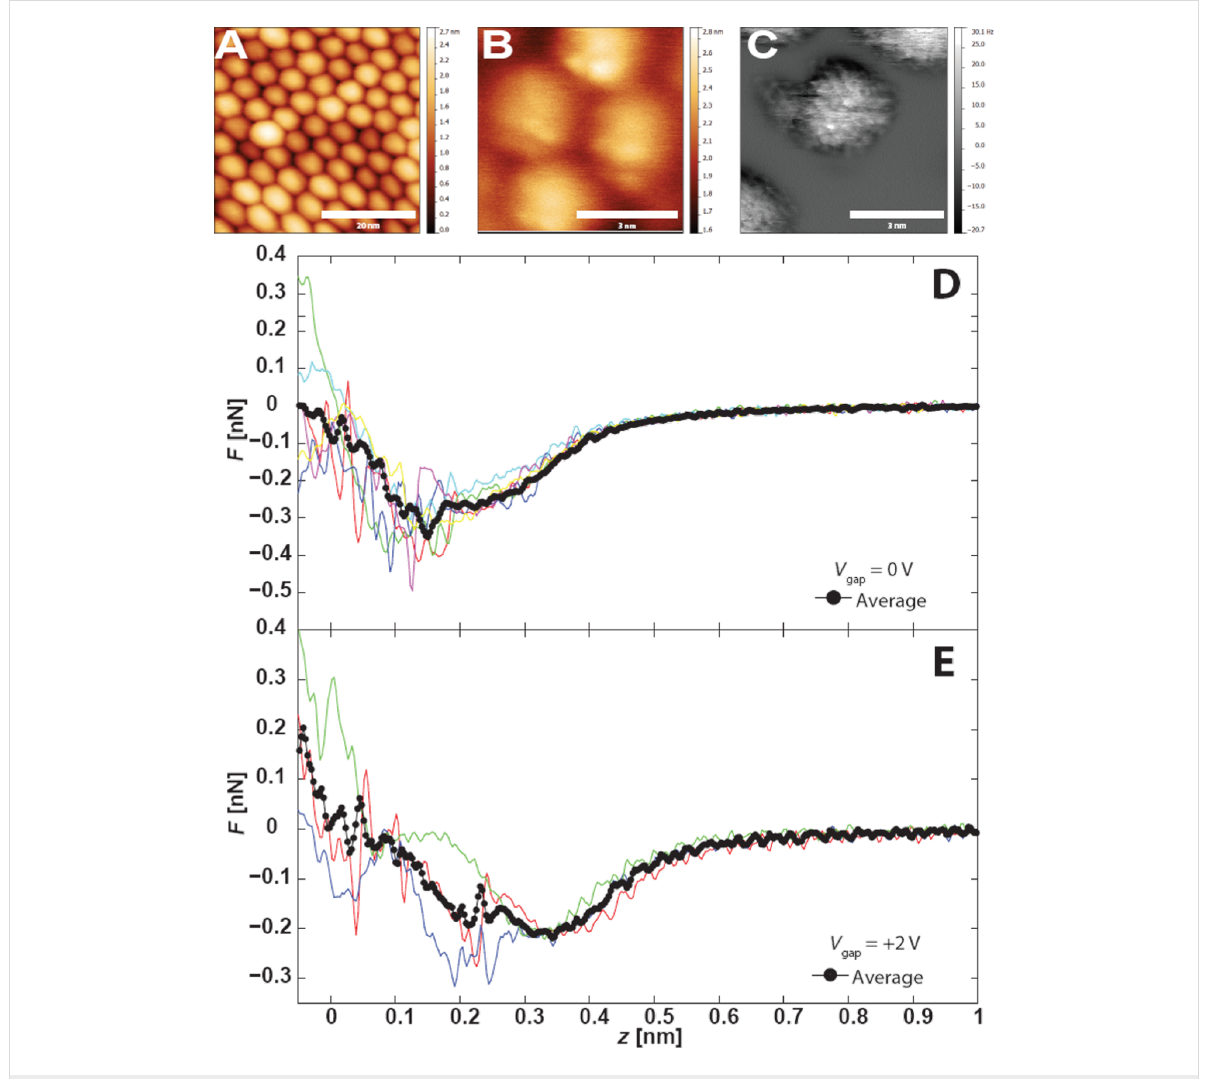
Figure 2: (A) Overview dSTM showing nanocrystal assembly, V gap = +2 V, = 20 pA. (B) DFM image acquired in the region shown in A. V gap = 0 V, Δ f = − 2.3 Hz, A 0 = 0.11 nm. (C) Constant height Δ f image of nearby region Δ z = − 0.7 nm. (D) Site-specific tip–sample force data taken over a single nanocrystal with zero applied bias. (E) Site-specific tip–sample force data taken over the same nanocrystal and height range with an applied bias of +2 V. Note that no tunnel current was detected during this